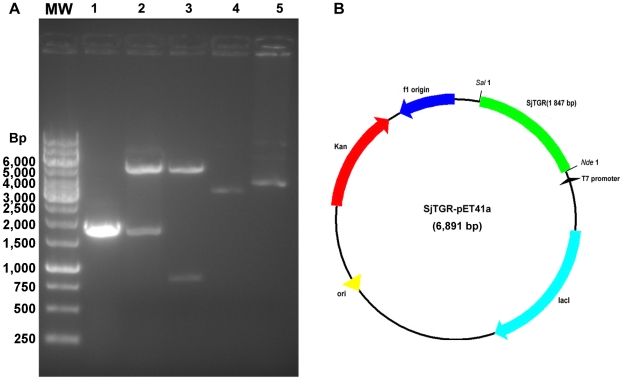
Analysis of recombinant SjTGR-pET41a by enzyme restriction.(A) Agarose gel (1%) electrophoresis of recombinant SjTGR-pET41a or pET41a vectors. Lane 1: Purified PCR amplified SjTGR gene fragment of about 1,800 bp. Lane 2: Products of recombinant plasmid SjTGR-pET41a digested by Nde I/Sal I. The sizes of the pET41a backbone and the SjTGR gene were about 5,000 bp and 1,800 bp, respectively. Lane 3: Products of plasmid pET 41a digested by Nde I/Sal I. The sizes of the fragments from Nde I/Sal I digestion of pET41a were about 5,000 bp and 900 bp. Lane 4: Undigested pET 41a plasmid of 5933 bp. Lane 5: Undigested recombinant plasmid SjTGR-pET41a of about 6,800 bp. Note that both undigested plasmids migrated lower in the gel due to the super-helical structures. MW: DNA molecular weight marker. (B) Schematic diagram of the SjTGR-pET41a plasmid showing relevant enzyme sites and the SjTGR insert size.